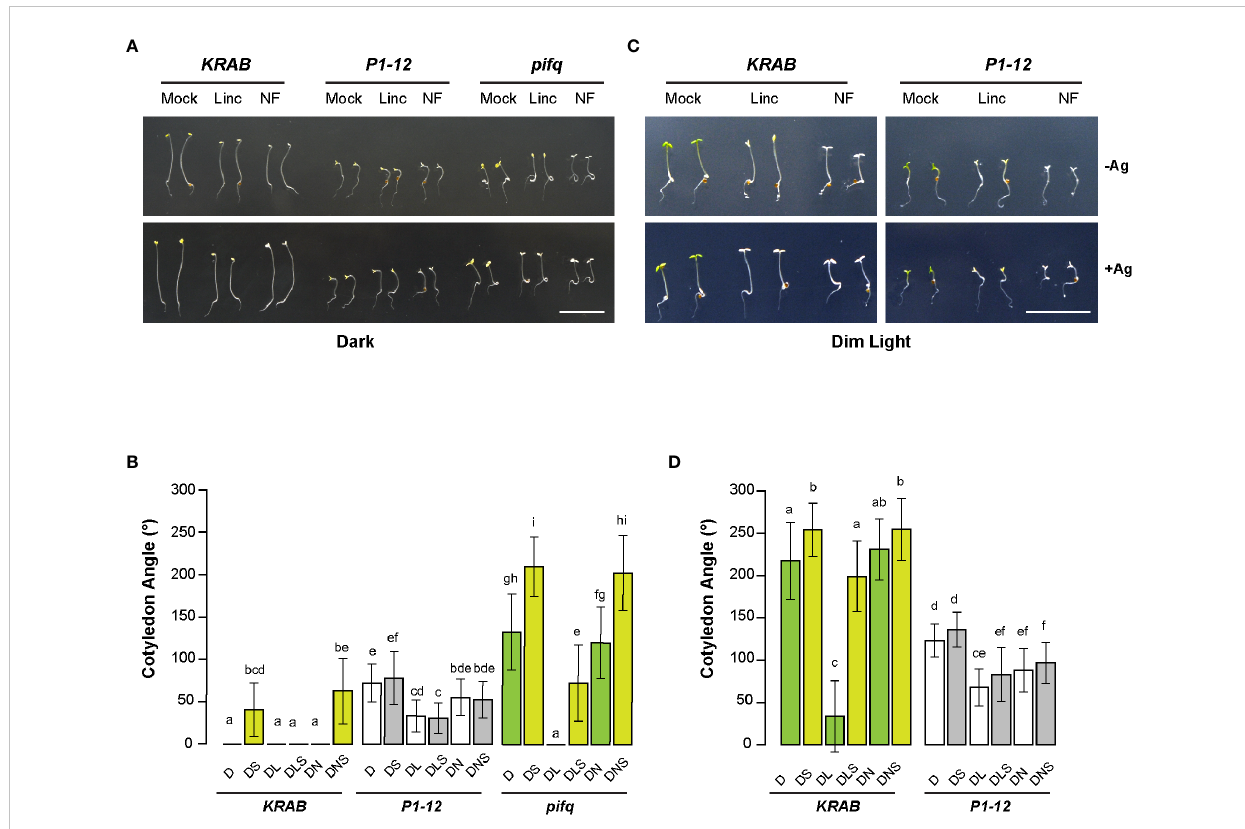
FIGURE 8 MORF2-dependent RS plays an antagonistic role to lincomycin-induced RS on plant photomorphogenesis. (A) Representative images of seedlings from indicated genotypes grown for 3 d in dark on media containing 0.25 m M Dex in the presence or absence of 5 m M AgNO3. Bar = 1 cm. (B) Quantitative analysis of cotyledon angle of seedlings shown in (A) . Different letters on the top of each bar indicate signi fi cant differences as analyzed in Figure 6C (n = 30-35). D: 0.25 m M Dex; L: 0.5 mM lincomycin; N: 5 m M NF; S: 5 m M AgNO3. (C) Representative images of seedlings from indicated genotypes grown for 3 d under continuous dim light on media containing 0.25 m M Dex in the presence or absence of 5 m M AgNO3. Bar = 1 cm. (D) Quantitative analysis of cotyledon angle of seedlings shown in (C) . Different letters on the top of each bar and D, L, N, and S are indicated as in (B)